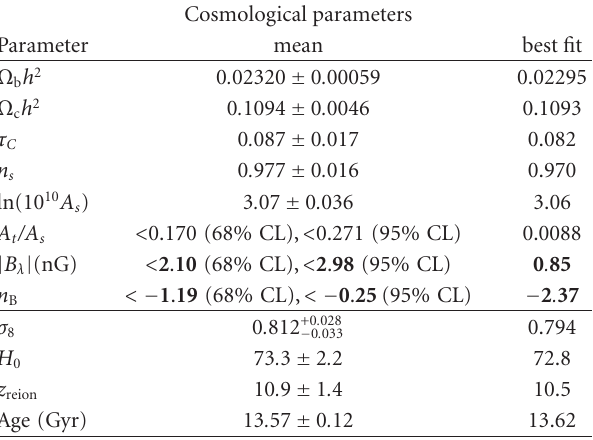
Figure 7: Curves of constant values for the σ 8 in the parameter plane of PMF amplitude B λ versus spectral index n B for the case of no correlation between the PMF and the matter density fluctuations. Red-dashed, blue-dotted, and green-bold curves show constant values of σ 8 = 1 . 0,0 . 9, and 0.8, respectively.